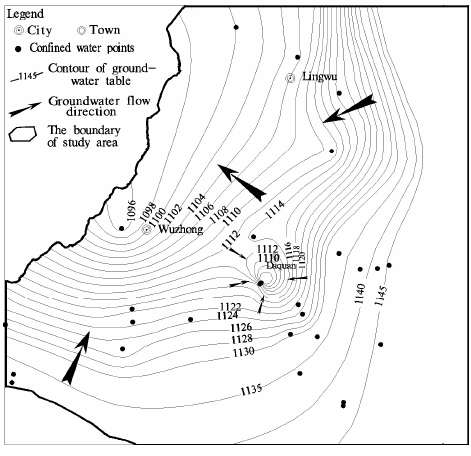
Figure 5. Confined water contour lines.